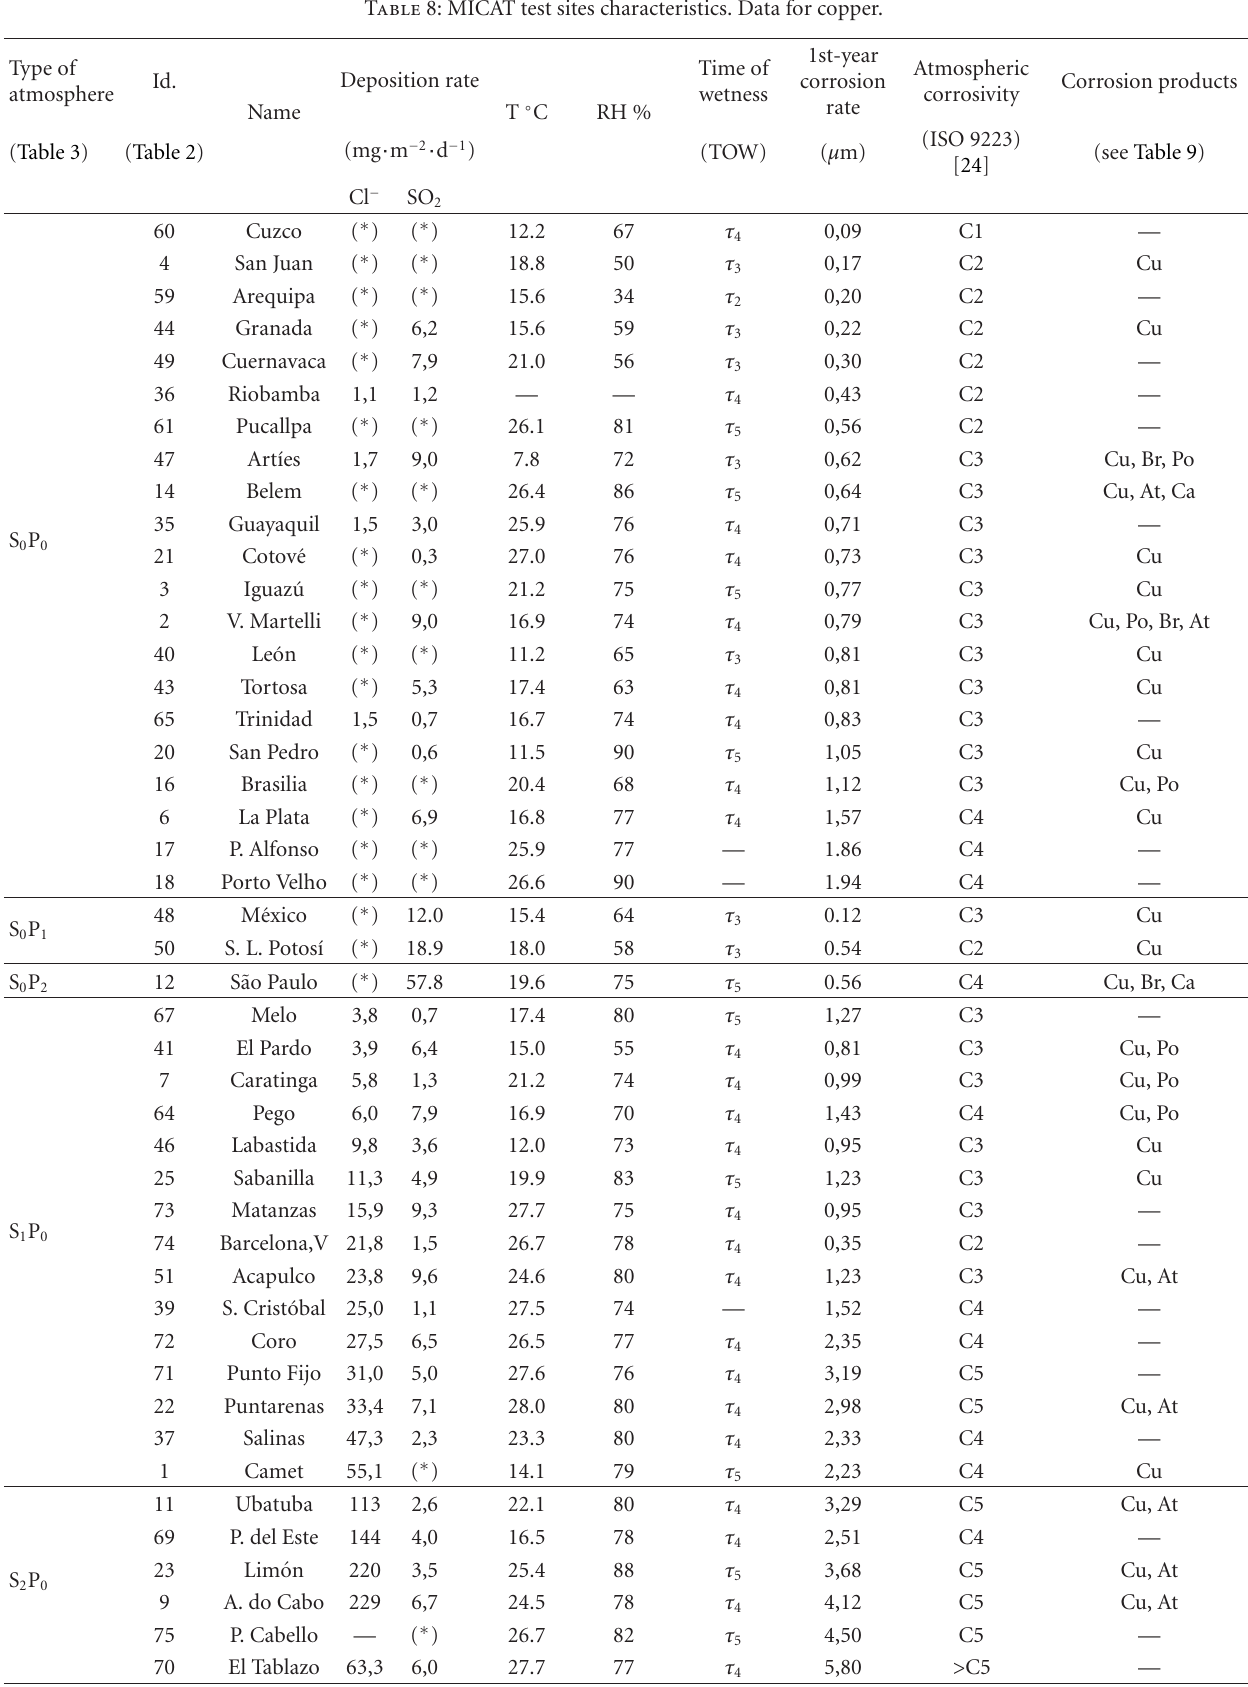
Table 8: MICAT test sites characteristics. Data for